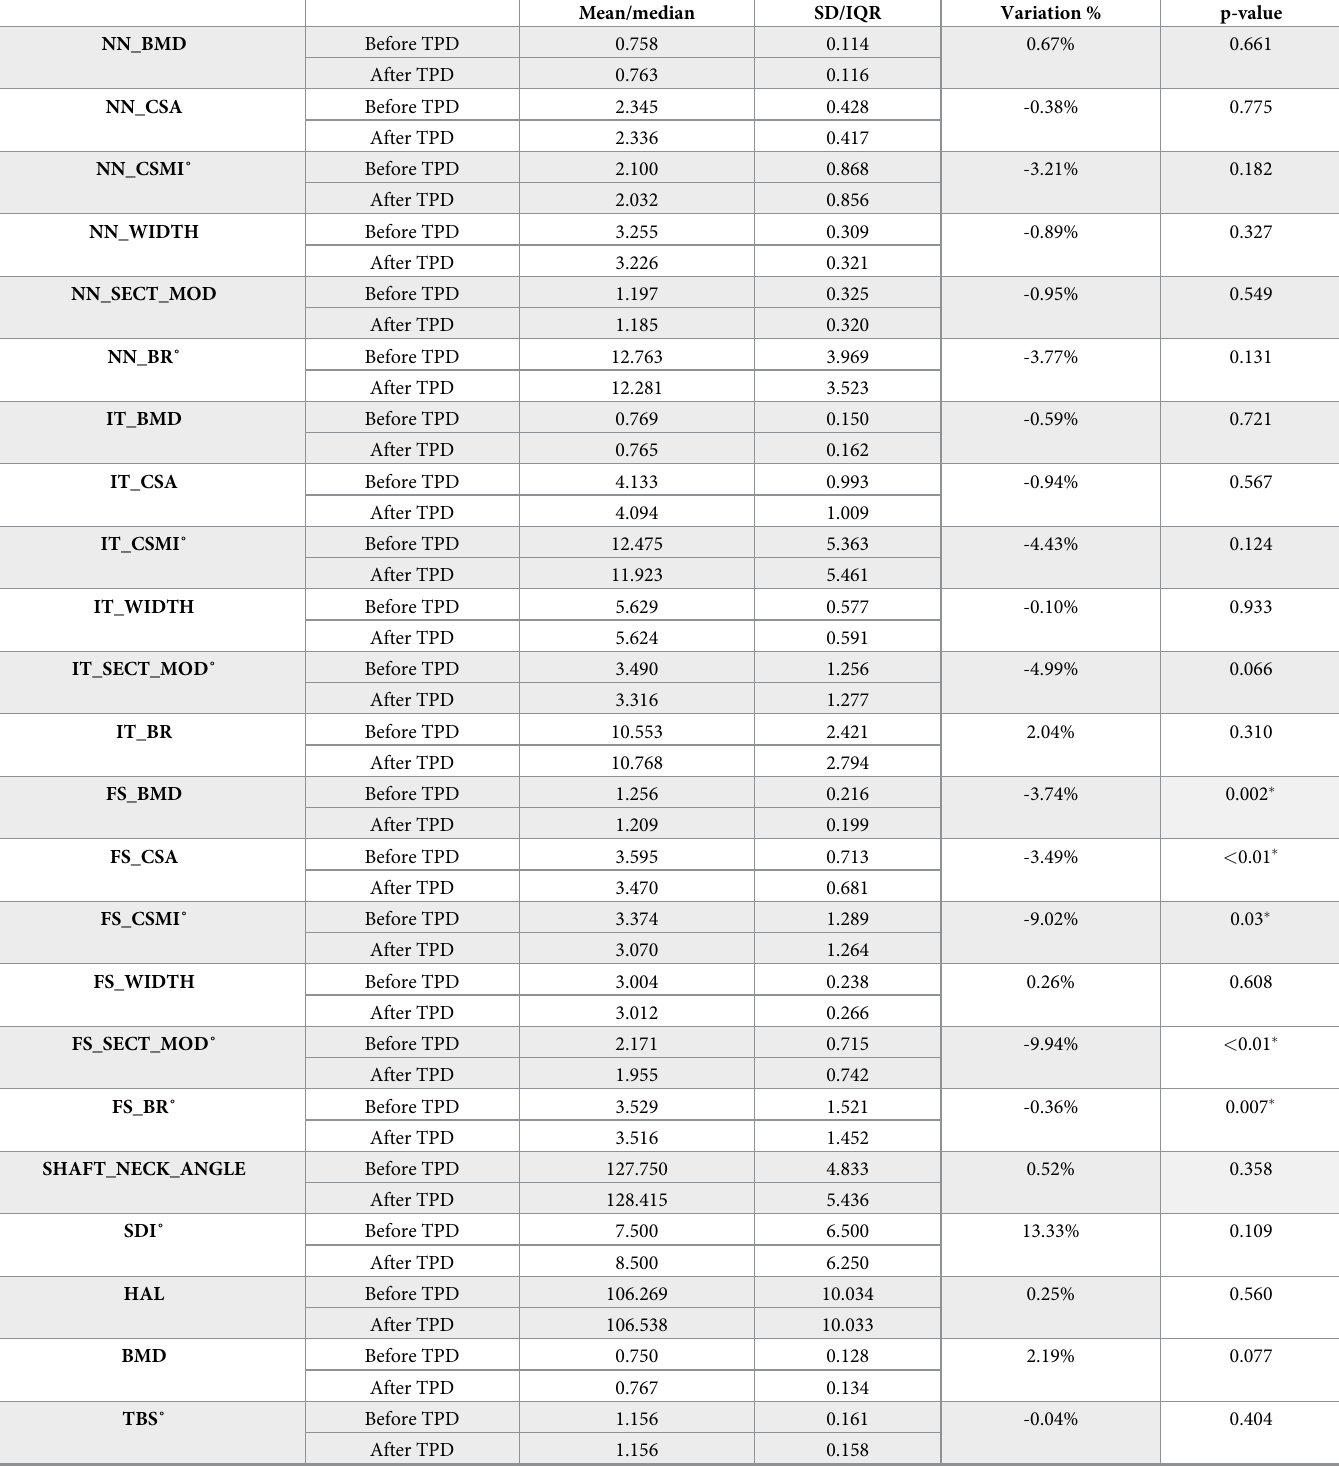
Table 3. SDI and DXA parameters of the “non-responders” (26 patients; 21 females and 5 males) before and after TPD